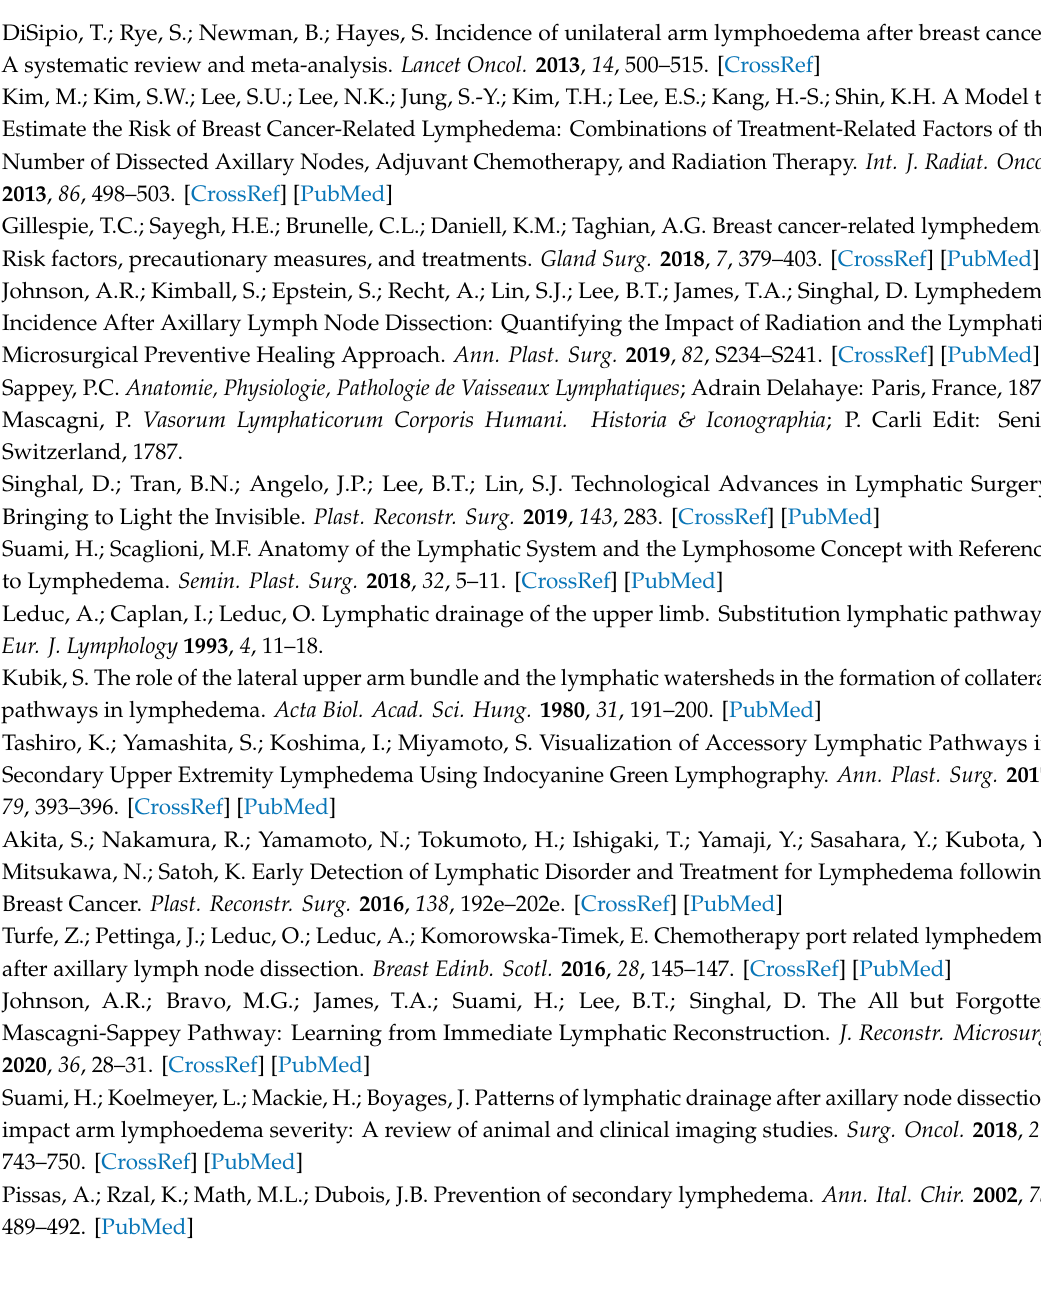
Table S1: Patient Cohort Cancer